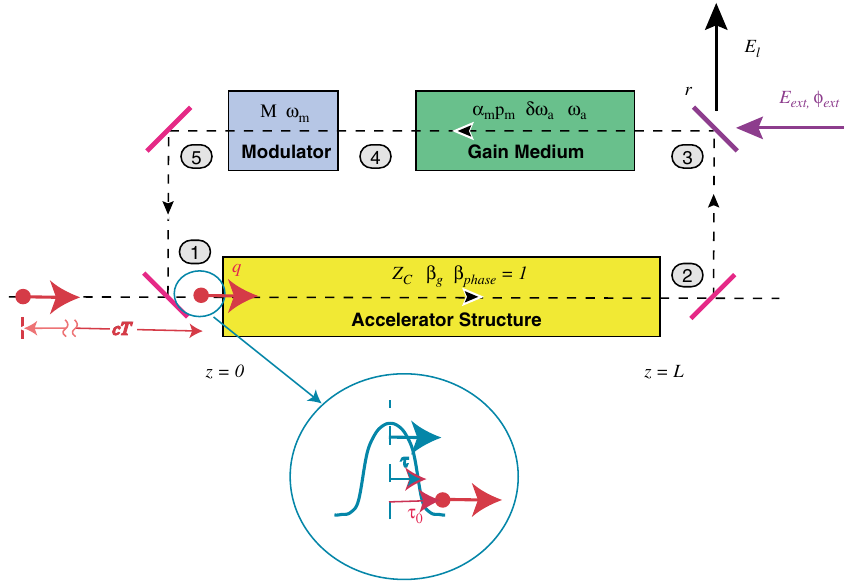
FIG. 3. (Color) The intracavity, actively mode-locked laser driven accelerator. The parameters of the different elements are discussed in the text, and the subscripts 1 ; . . . ; 5 refer to the locations indicated in the